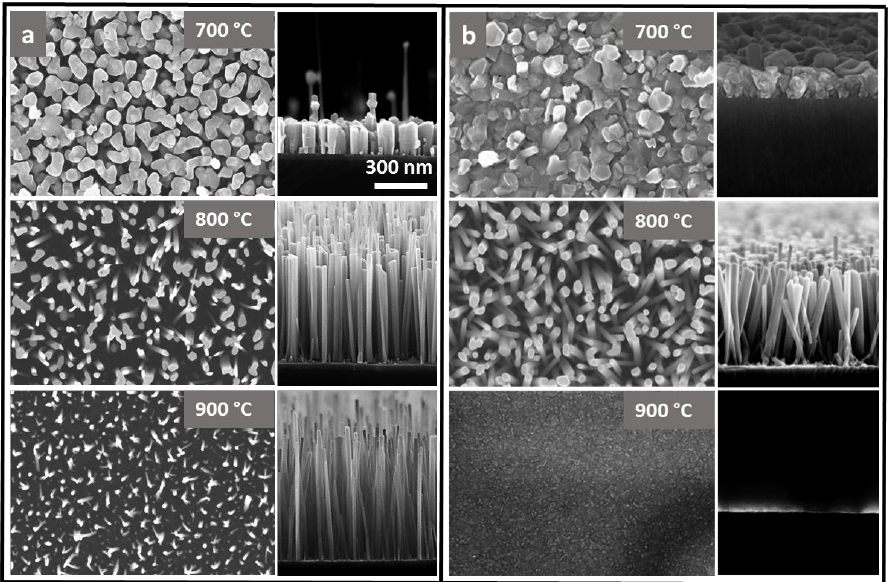
Figure 3. SEM images of GaN NRs grown on ( a ) TiN/Si and ( b ) ZrB 2 /Si templates at different temperatures. The same scale applies to all images.